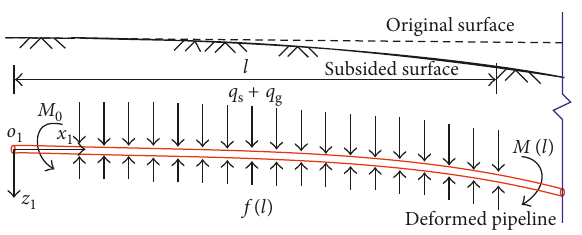
Figure 2: Stresses under pipeline-soil coordinating deformation.